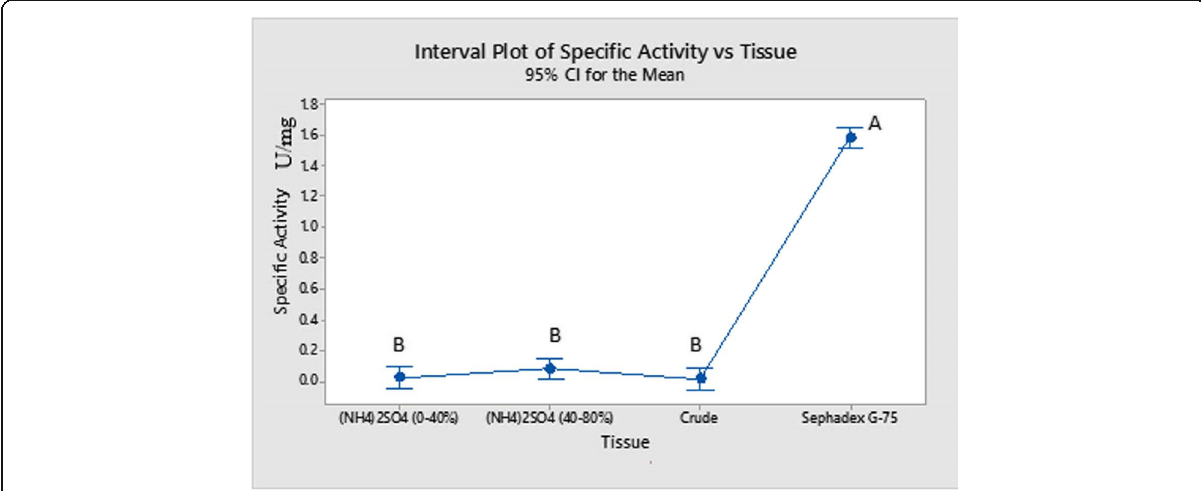
Fig. 2 Specific activity of fat body lipase before purification and during steps of purification. Different letters indicate significant differences ( p < 0.05). (no. of replicates =